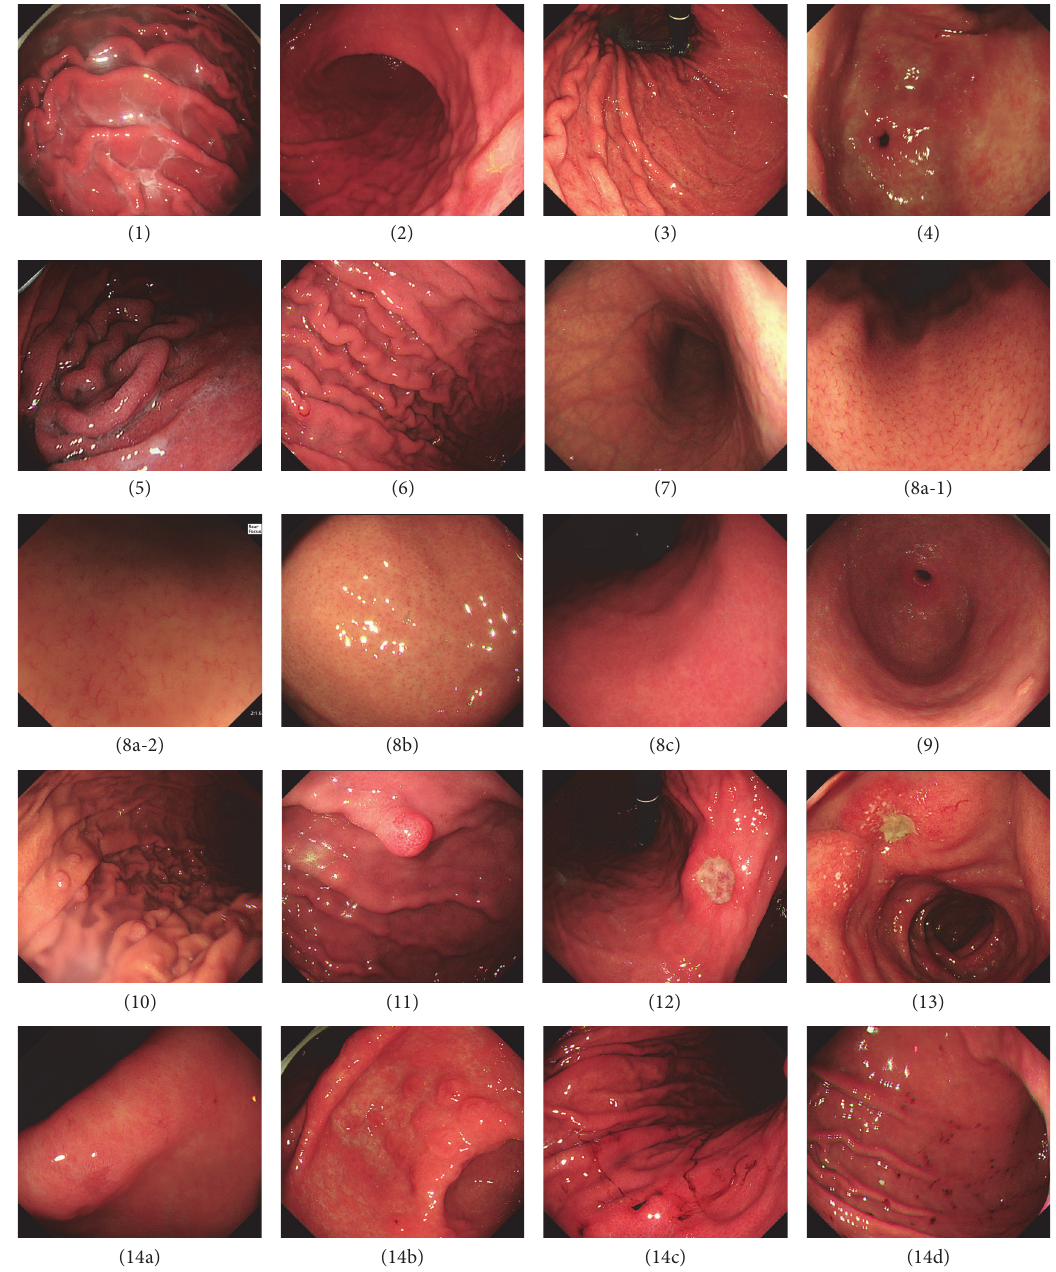
Figure 1: Endoscopic features identified in this study. (1) The mucus on the gastric mucosa, (2) diffuse redness, (3) spotty redness of fundic mucosa, (4) patchy redness, (5) enlarged fold, (6) mucosal edema/swelling (fundic/pyloric mucosa), (7) red streak, (8) regular arrangement of collecting venules (RAC): (8a-1) RAC (type R) observed with conventional endoscope, (8a-2) RAC (type R) observed with magnifying endoscope, (8b) RAC (type I), and (8c) RAC (type D), (9) Xanthoma, (10) fundic gland polyp, (11) hyperplastic polyp, (12) gastric ulcer, (13) duodenal ulcer, and (14) erosion: (14a) flat type , (14b) raised type, (14c) hemorrhagic erosion, and (14d) bleeding spot